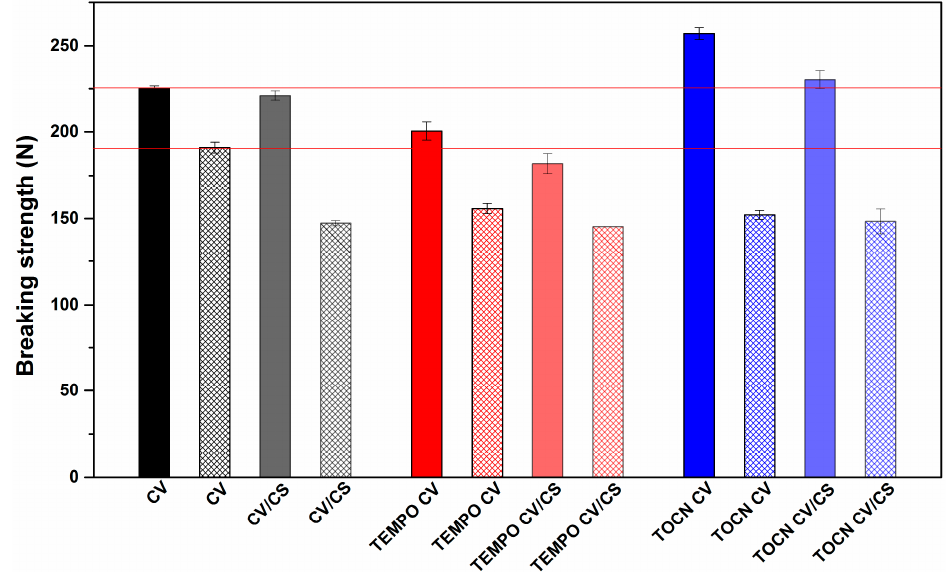
Figure 4. Breaking strength of pristine and pretreated viscose fabrics before and after chitosan functionalization: In warp (solid fill) and in weft direction (pattern fill).